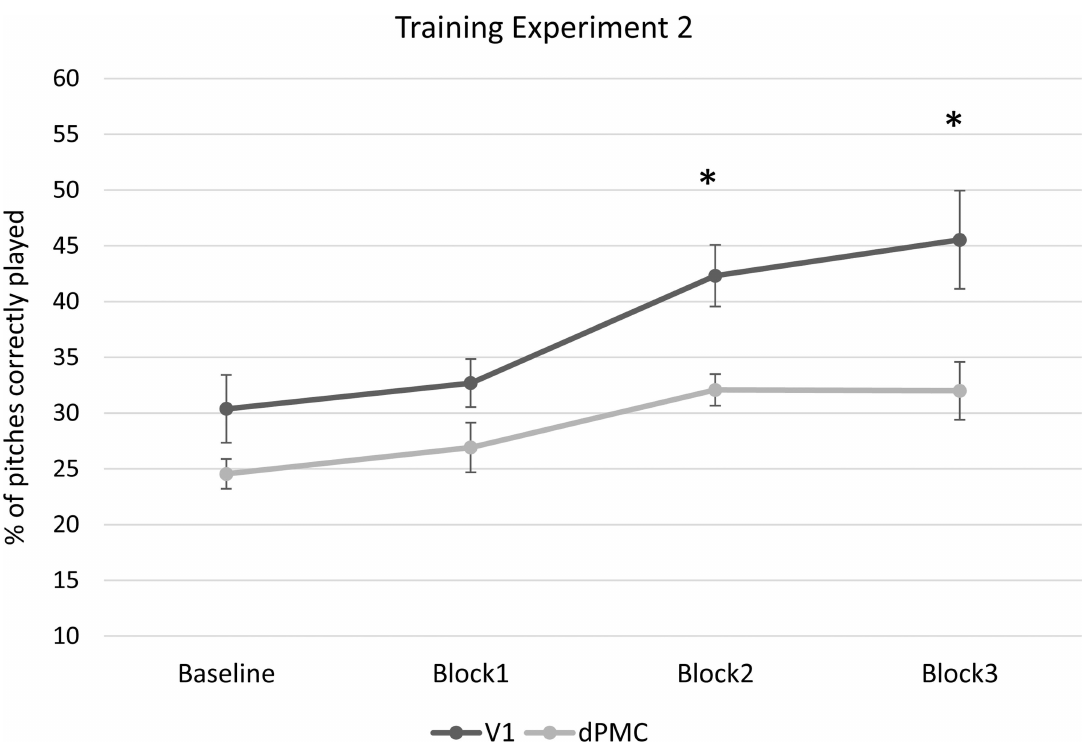
Fig 6. Results of the Pitch matching task of Experiment 2 (scrambled mapping). Columns represent averagedata with standard error bars. The y-axis represents percent correct scores plotted across the TMS site (dPMC and V1). As indicated by the asterisk, TMS over the dPMC significantlyreduced participants’ accuracy compared to the V1 stimulation. Horizontal dashed line indicatesthe level of chance (25%).